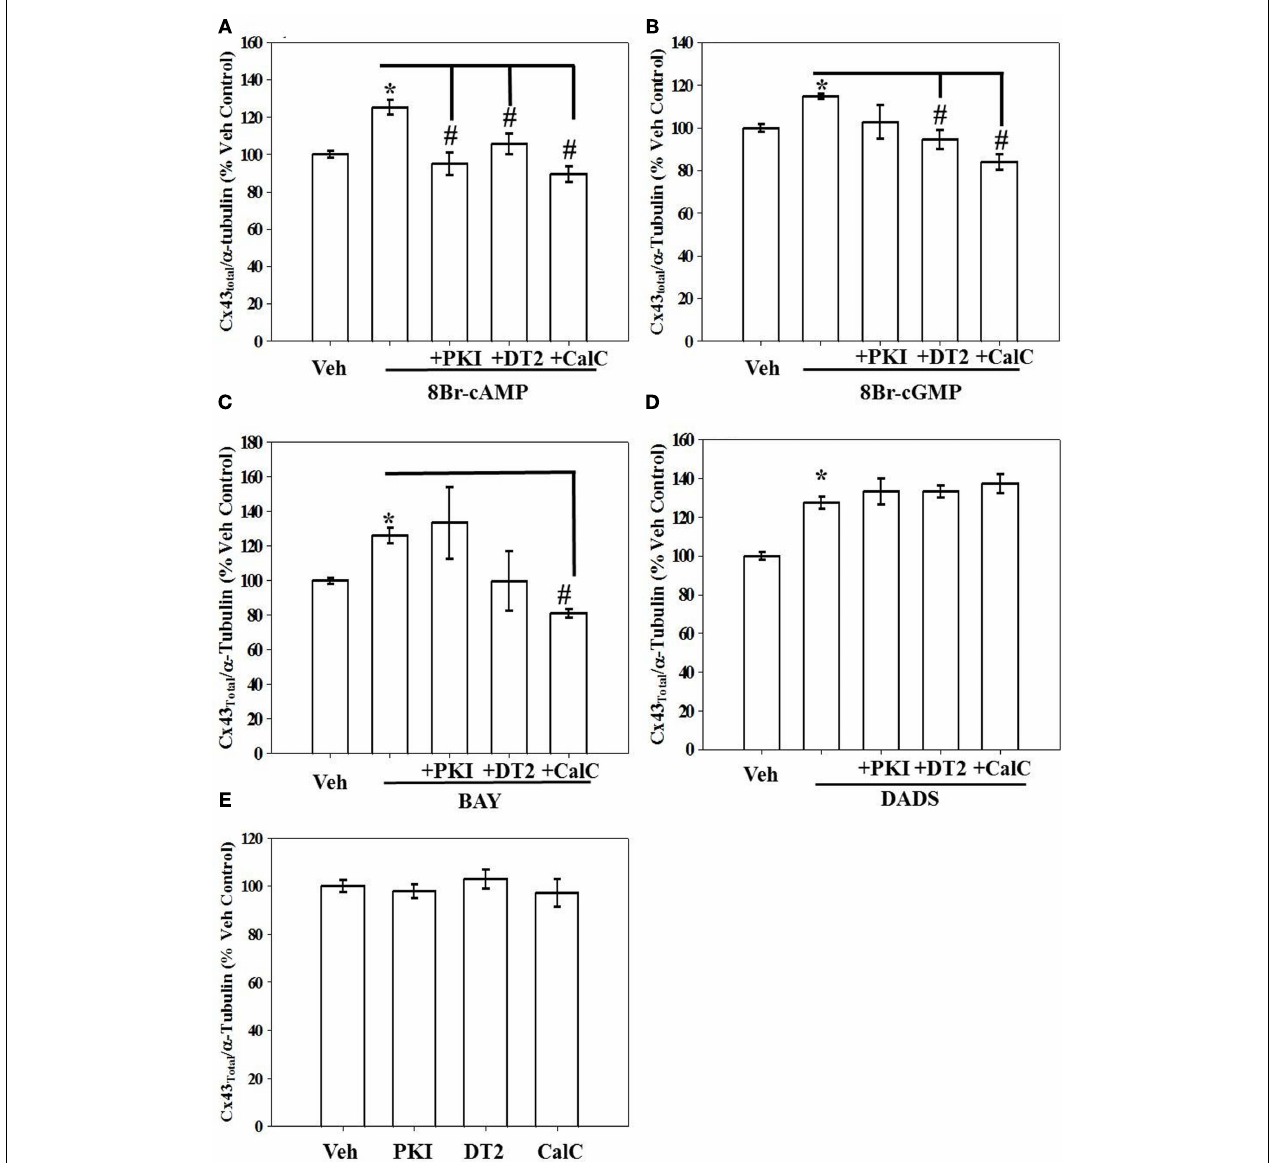
respectively. (D) Stimulation of Cx43 expression in the presence of DADS was not dependent on PKA, PKG, or PKC. (E) Treatment with any individual kinase inhibitor did not affect total basal Cx43 expression compared with vehicle controls. Data are mean ± SE from n = 4–7 for each treatment. Student–Newman–Keuls method for multiple comparisons following one-way ANOVA was used. * p < 0.05 compared with normalized vehicle controls; # p < 0.05 comparing inhibitors to agonists alone normalized to vehicle